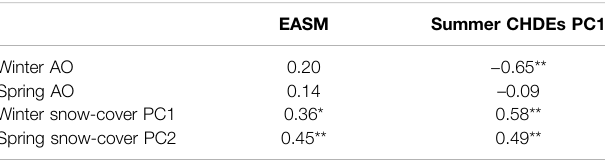
TABLE3| Correlationcoef fi cientsofthePC1ofwintersnowcoverandthePC2of spring snow cover with the EASM index and the PC1 of summer CHDEs during 1981 –